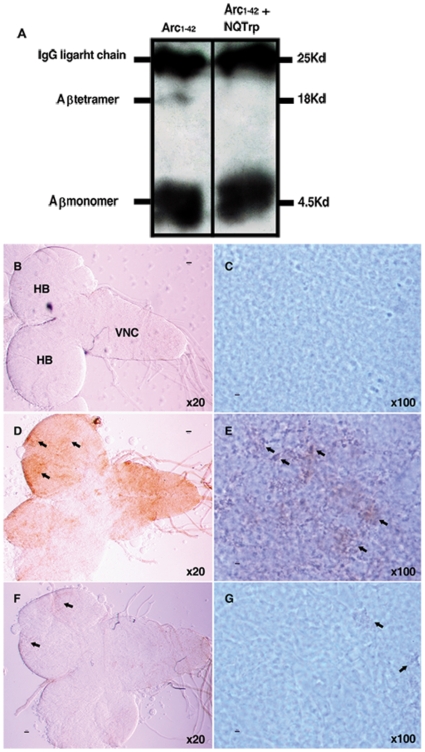
Effect of NQTrp on Aβ in larvae brains.
A. Head extract from 6 days old Aβarc1-42-expressing flies unfed (left) and fed (right) with 0.75 mg/mL NQTrp (N = 25 in each group). Accumulation of Aβ tetramers is evident only in Aβarc1-42 flies which were not fed with NQTrp. (B–G) Immuno-staining of 3rd instar larval brains with specific Aβ antibody 6E10. (B, C) Control animals not expressing any Aβ (elav-GAL4/+; +/+). (D, E) Aβarc1-42-expressing animals fed with regular fly food. (F, G) Aβarc1-42-expressing animals fed with NQTrp (elav-GAL4/+; UAS-Aβarc1-42/+). N = 10 for each class examined. HB – hemi-brain; VNC – ventral nerve cord. Arrows indicate Aβ accumulation.